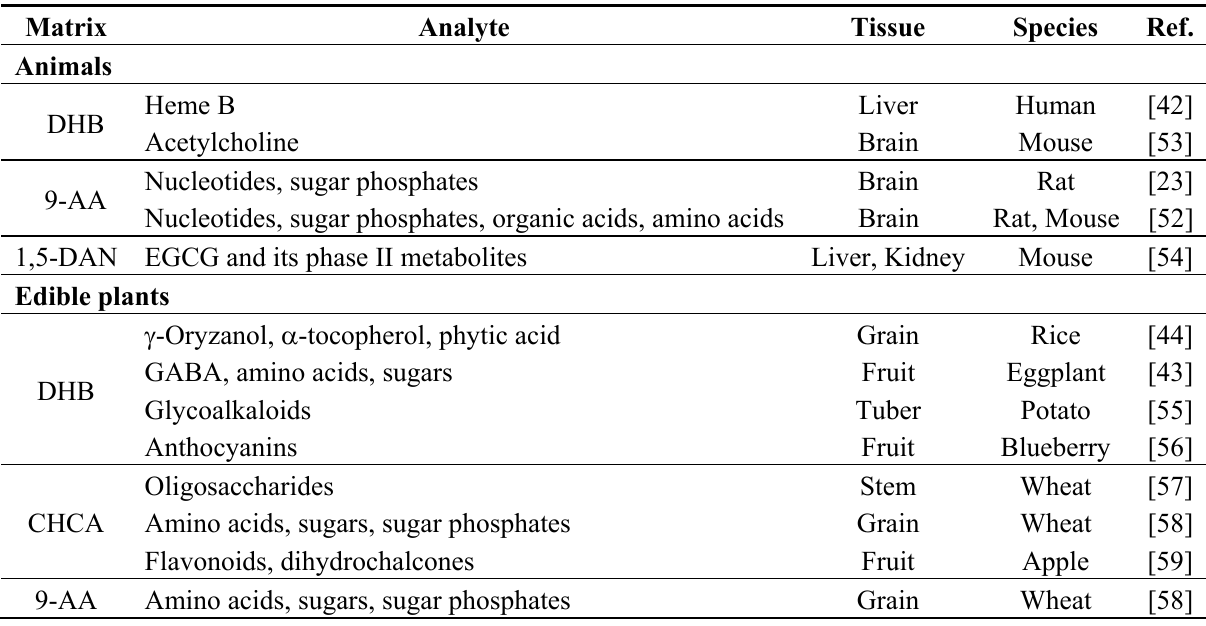
Table 1. Published literature describing the application of MALDI-MSI for endogenous metabolites and dietary phytochemicals in animal and edible plant tissues.